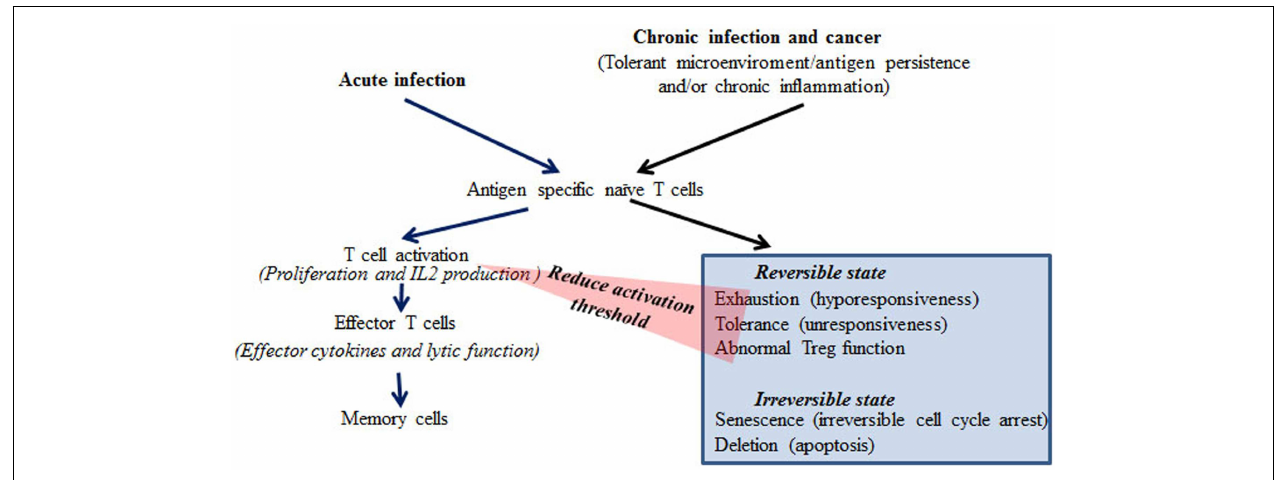
FIGURE 1 | Differential responses ofT cells during acute and chronic infection or cancer